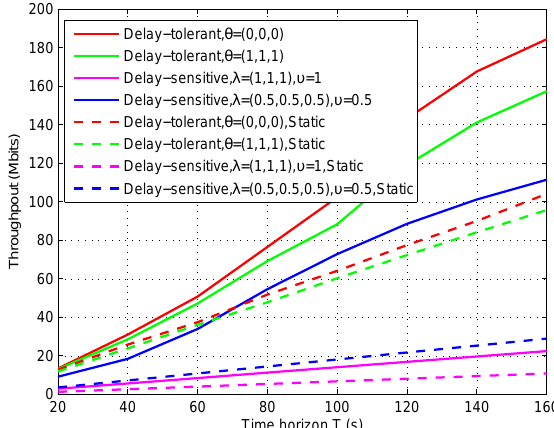
Figure 13. The throughput of the relaying system versus period T